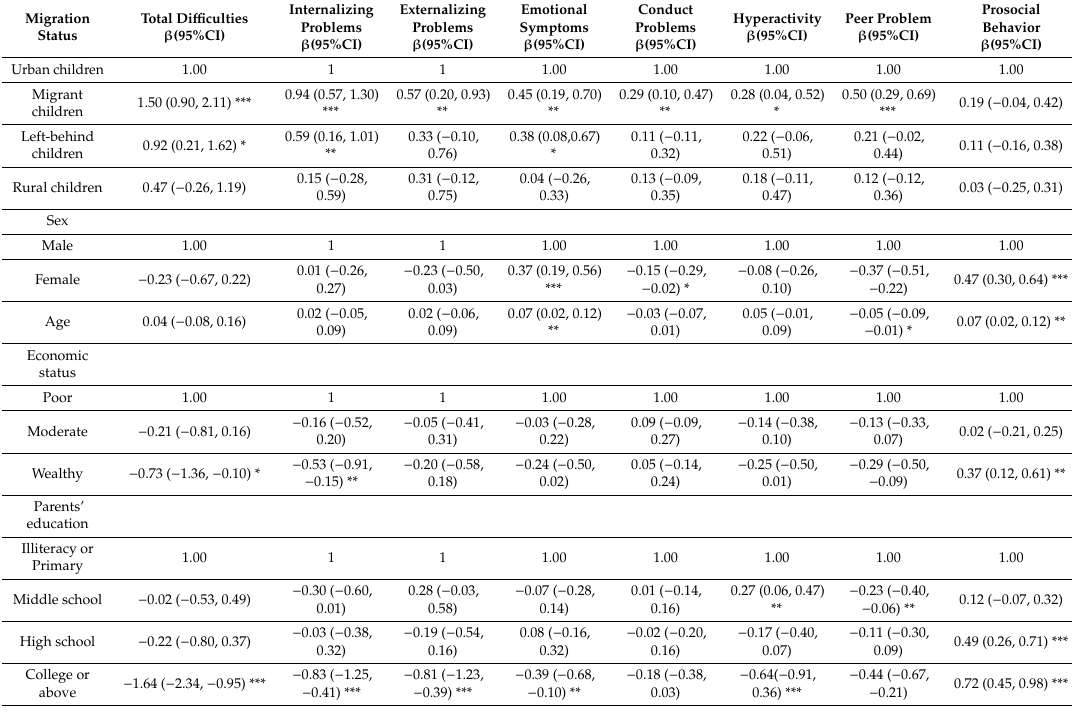
Table 3. Regression coefficients for SDQ-C outcomes after adjustment for sociodemographic characteristics. Migration